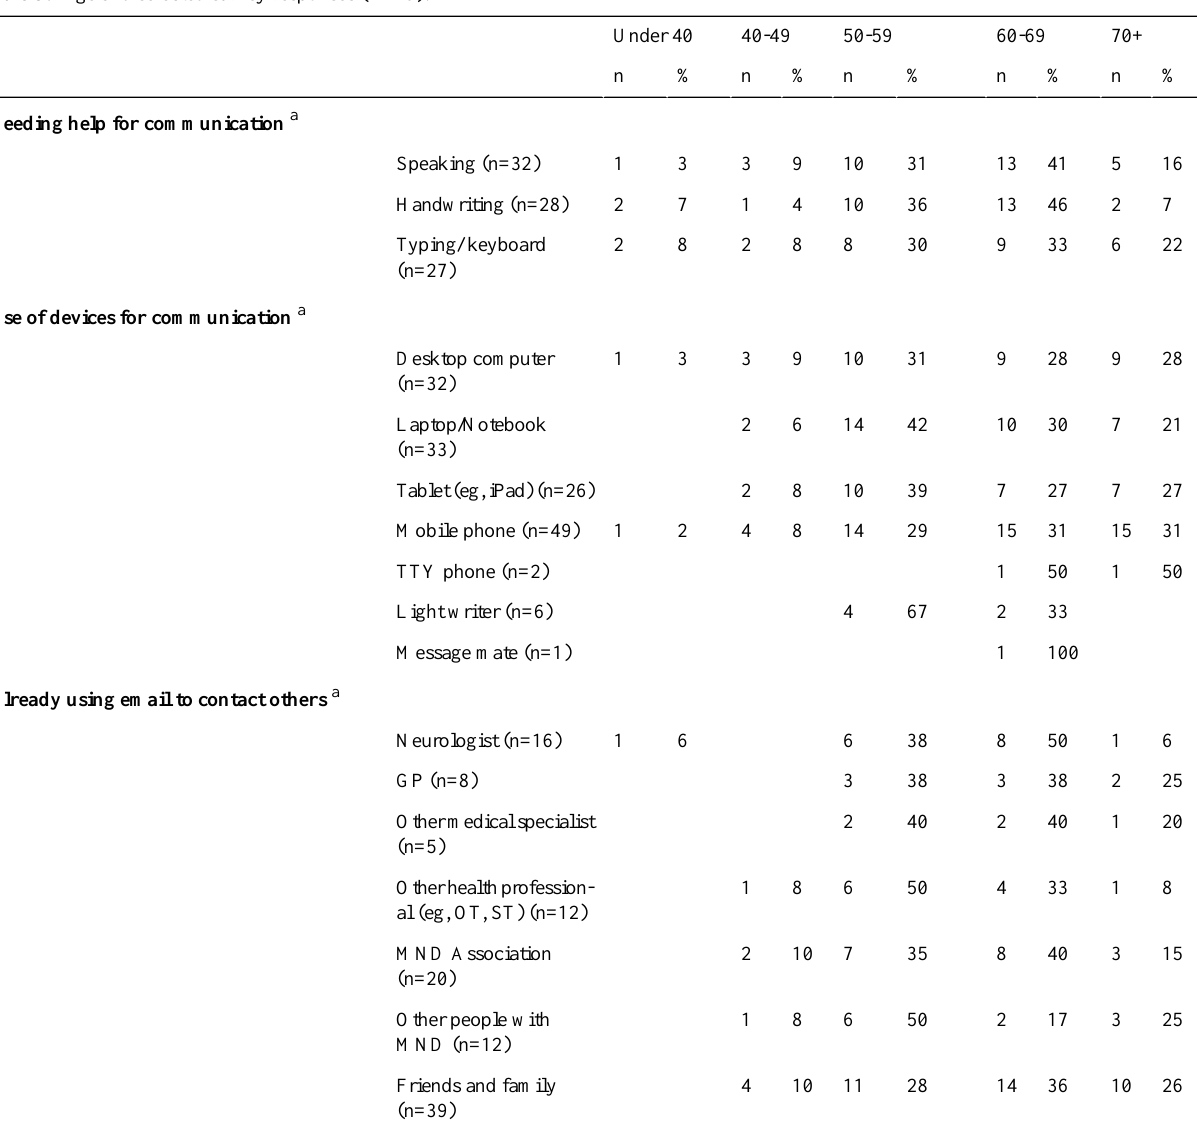
Table 3. Age and selected survey responses